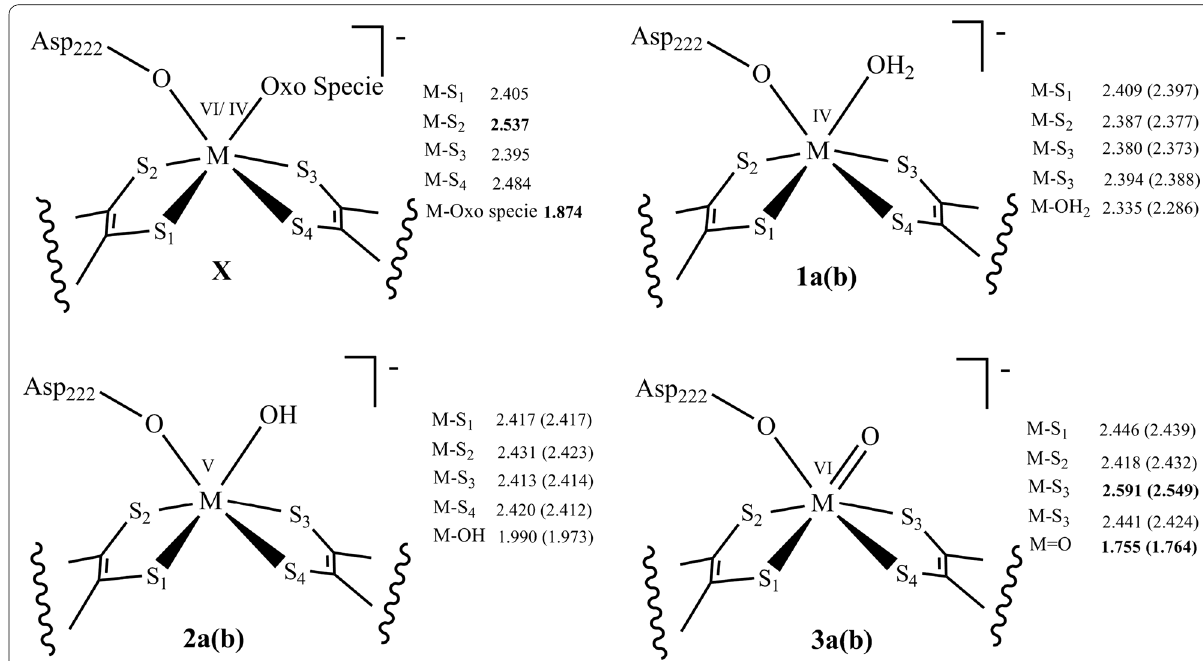
Fig. 5 The chemical structures of the active site model complex of protein X-ray crystal structure of Nar (PDB ID 1R27) [19] represented as X as well as the active site model complexes derived from the protein X-ray crystal structure of Nar (PDB ID 1R27) [19] showing metal–sulfur and metal–oxo specie bond distances. Where, model 1 represents the presence of M–OH 2 bond, 2 represents the presence of M–OH bond, 3 represents the pres- ence of M O bond, however, a and b represents the Mo and W, respectively, as the metal at the active site =